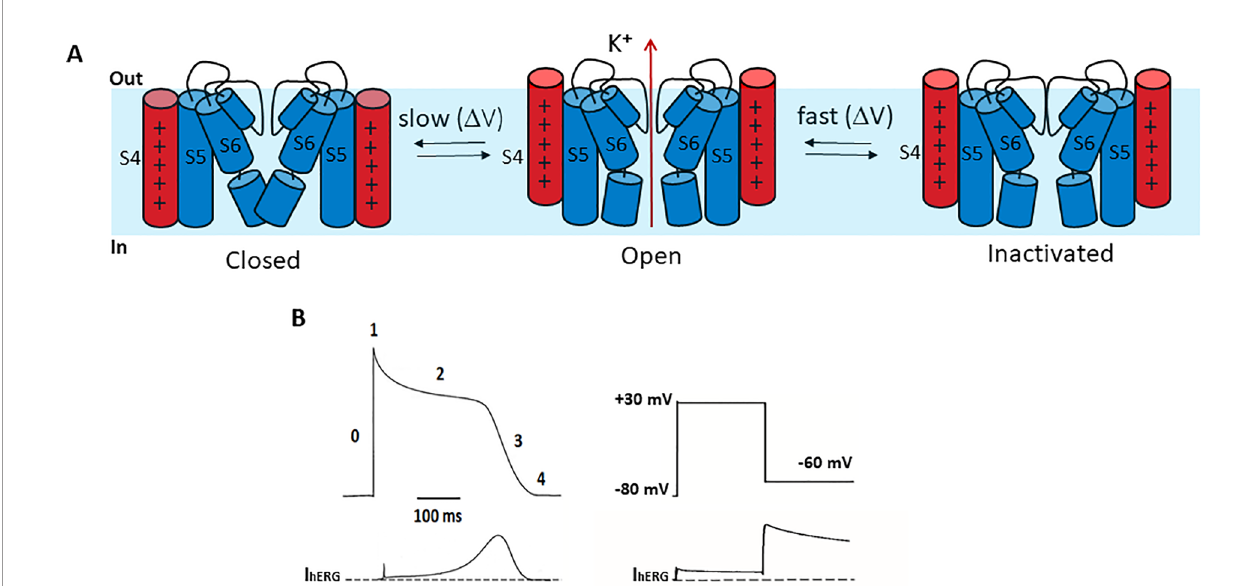
FIGURE 2 | hERG channel gating. (A) Schematic of the hERG channel gating scheme representing the state transitions between the closed and open stated being slower than transitions between open and inactivated states. (B) Left. A stylized ventricular cardiac action potential waveform (top) with fi ve distinct phases and the corresponding current conducted by hERG channels (bottom). Right. In a step voltage clamp experiment, depolarization to +30 mV activates and quickly inactivates hERG channels, producing a small outward current. Upon repolarization to − 60 mV hERG channels quickly recover from inactivation, producing a large resurgent current that decays slowly due to slow